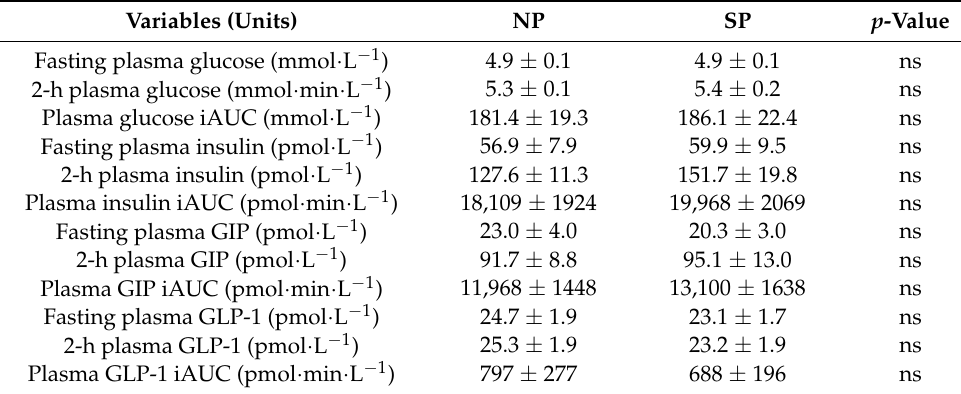
Table 2. Mixed meal test